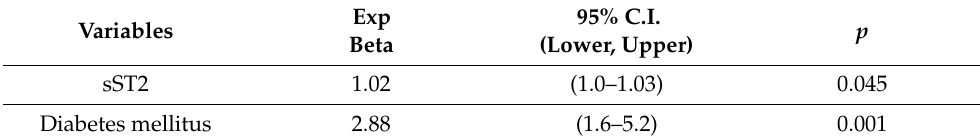
Table 6. Adjusted multivariate analysis for risk factors associated with any MACE.